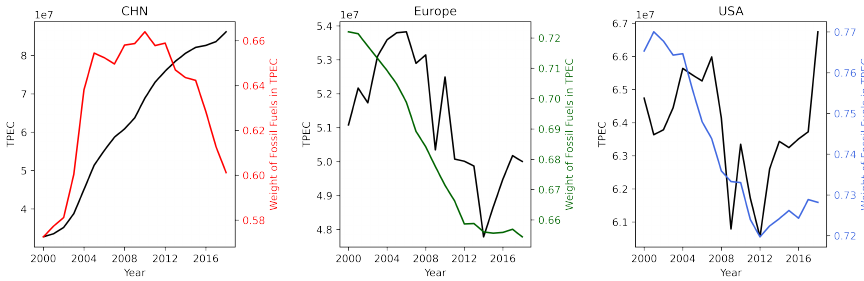
Figure 15. The evolution of the TPEC and the share of fossil fuels in TPEC.